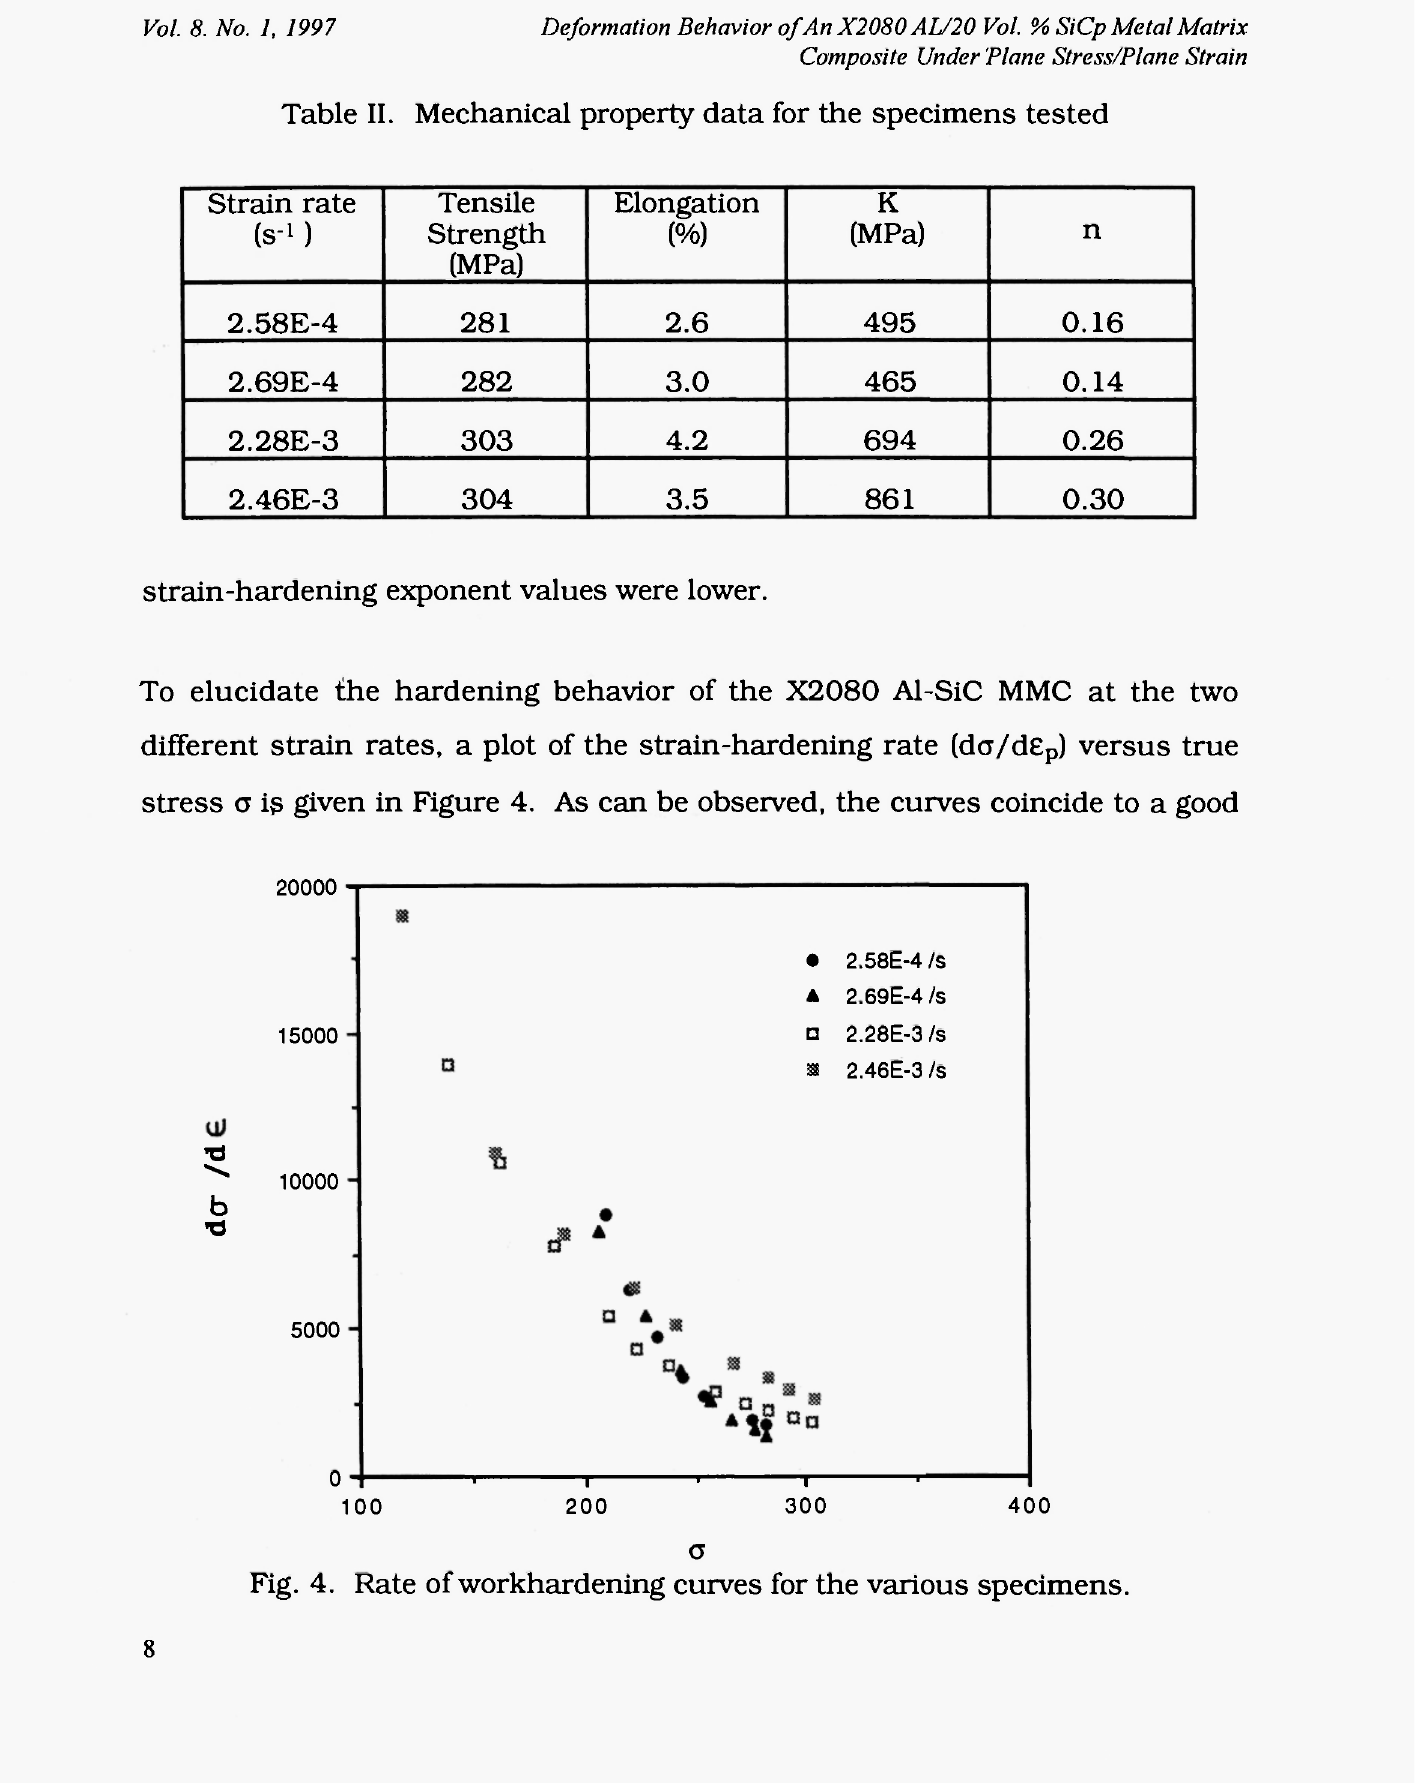
Table II. Mechanical property data for the specimens tested